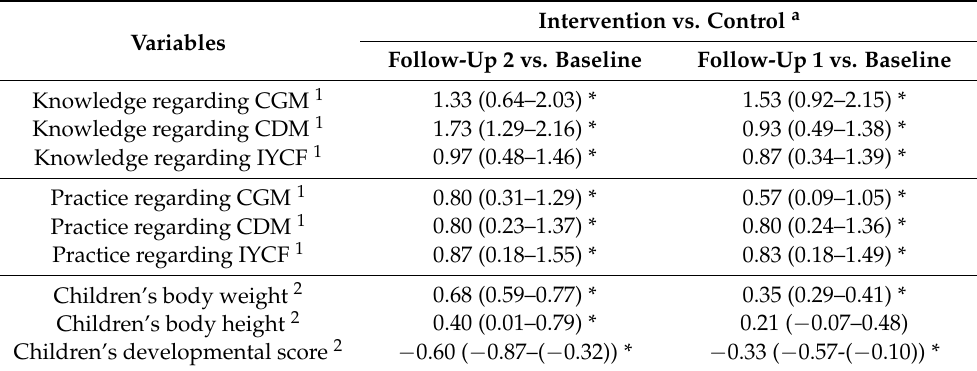
Table 4. Evaluation of the interaction effect between intervention and time on different research outcomes using adjusted DID based on GEE